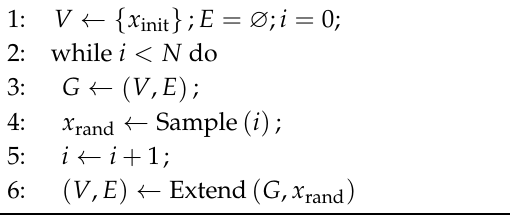
Algorithm 2: RRT main algorithm